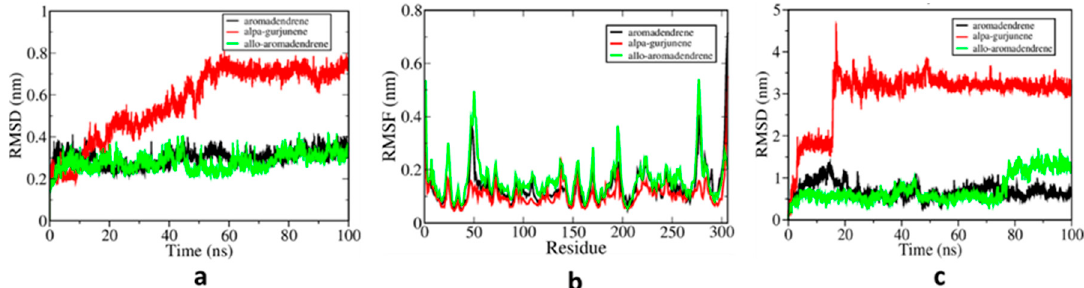
Figure 5. ( a ) Root mean square deviation (RMSD) of backbone carbon (C α ) atomic positions of the Mpro relative to the starting structure measured from the 100 ns trajectories, ( b ) per residue root mean square fluctuations (RMSF) of C α atomic positions measured over the last 30 ns from protein conformations, and ( c ) RMSD of ligand atomic positions relating to the starting structure measured from the 100 ns trajectories with allo-aromadendrene (green), aromadendrene (black), and α -gurjunene (red).